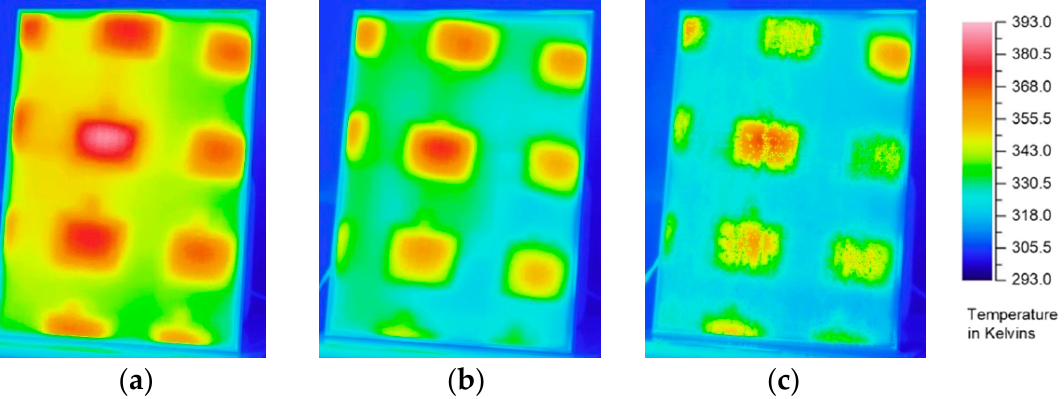
Figure 8. Temperature distribution on the front side of the 50 Wp PV panel after 15 min of the experiment: ( a ) without cooling, ( b ) with air cooling, ( c ) with a water cooling system (visible areas with higher temperature result from the configuration of the light source).